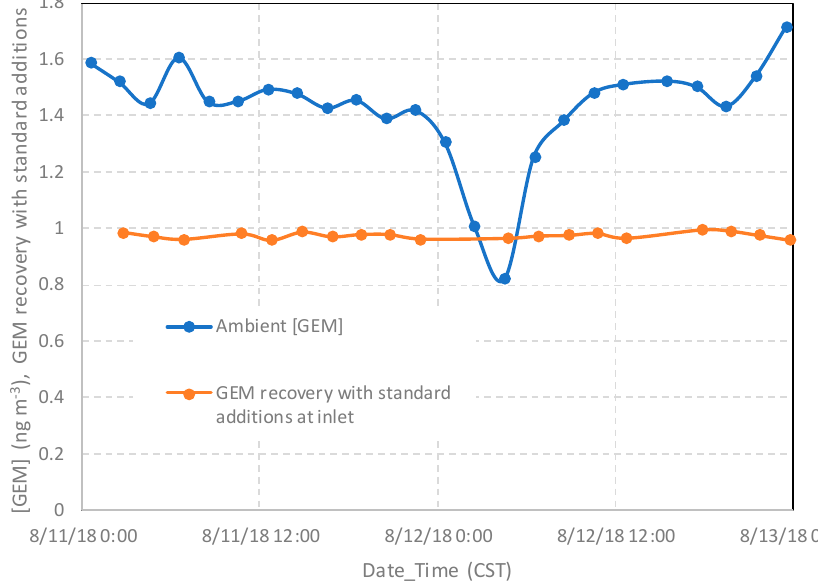
Figure 14. Time series of ambient [GEM] and GEM recovery with standard additions to both the inlet and upstream of the denuder of the sampling unit on the tower at the Beltsville site on August 11 and 12, 2018. The GEM recovery is expressed as fractions and is calculated by the equation of ([GEM] sa − [GEM] amb )* Sample Volume / (GEM amount injected), where [GEM] sa is the total [GEM] concentration (ambient [GEM] + added [GEM]) during standard additions, [GEM] amb is the ambient GEM concentration, which is calculated as the mean of the GEM concentrations before and after the standard addition. The injected GEM amount is calculated from the the mercury source permeation rate times the permeation source injection